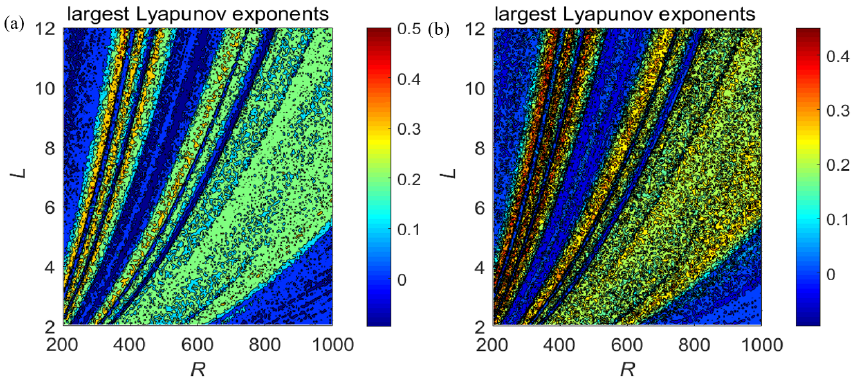
Figure 11. Diagram of maximal Lyapunov exponents with different initial condition: ( a ) [0.1 0 − 1 0.1] ( b ) [0.1 0 1.68 0.1].